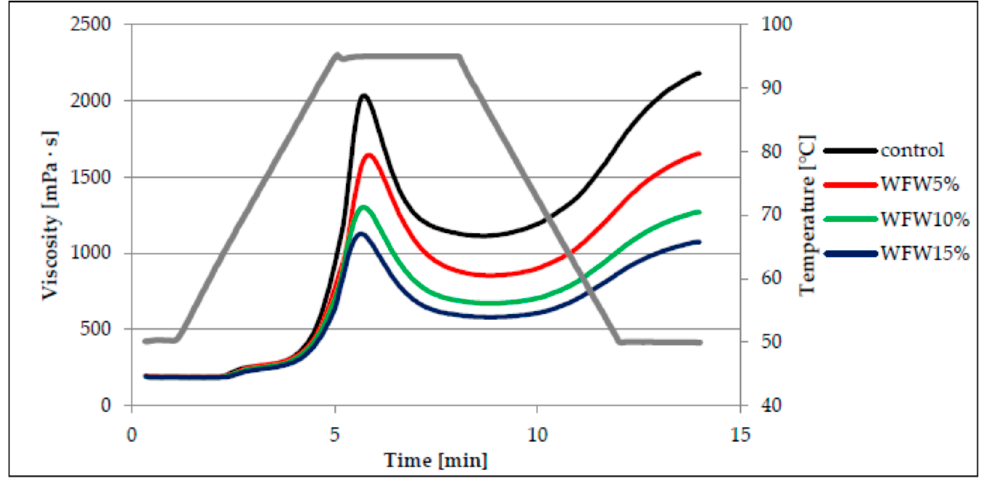
Figure 2. Pasting curves of wheat flour dispersion (control) and samples with walnuts additions.